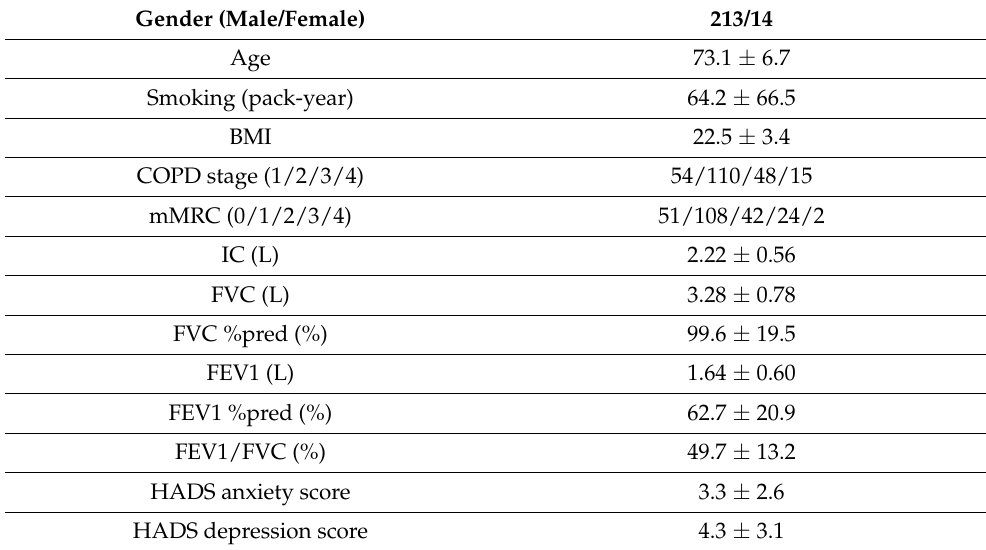
Table 1. Patient characteristics.